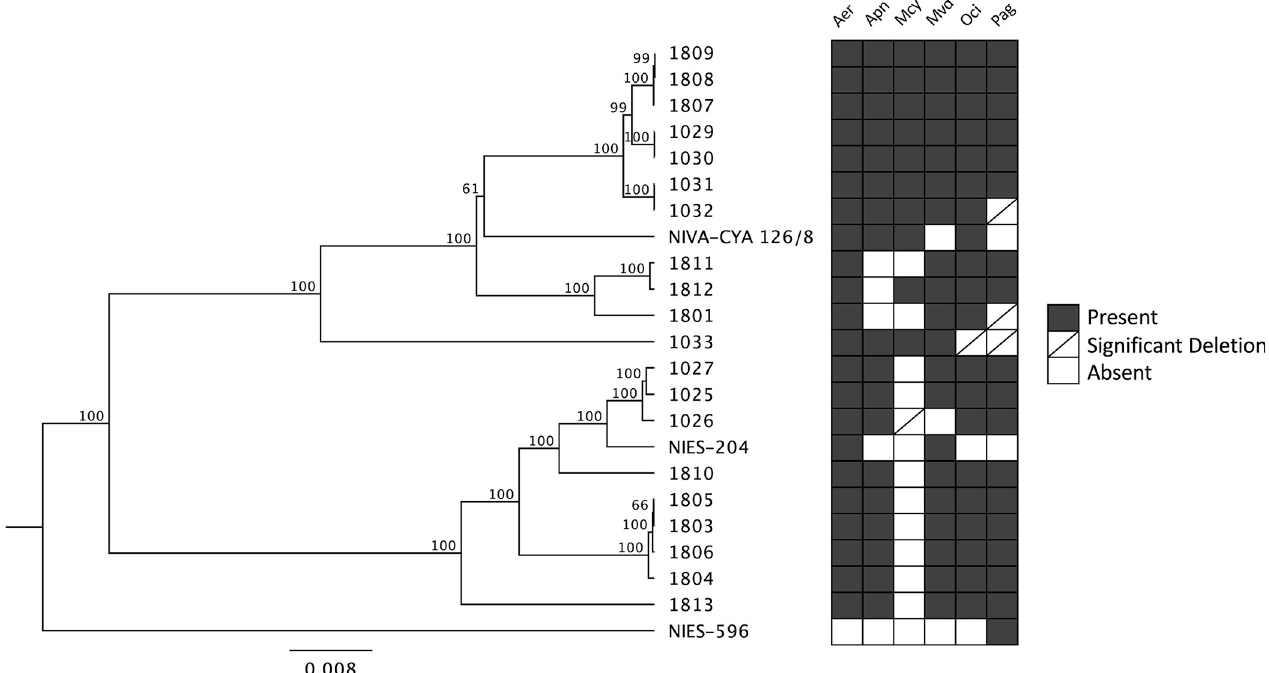
Fig 5. Oligotype phylogenetic tree, generated by the concatenation of the alignments for mcy , oci , aer , apn , mvd , and pag . The table relates presence and absence of specific secondary metabolite gene clusters to understand the relatedness of each isolate. The bar represents the horizontal distance matrix used to scale the branch length as a function of substitutions per